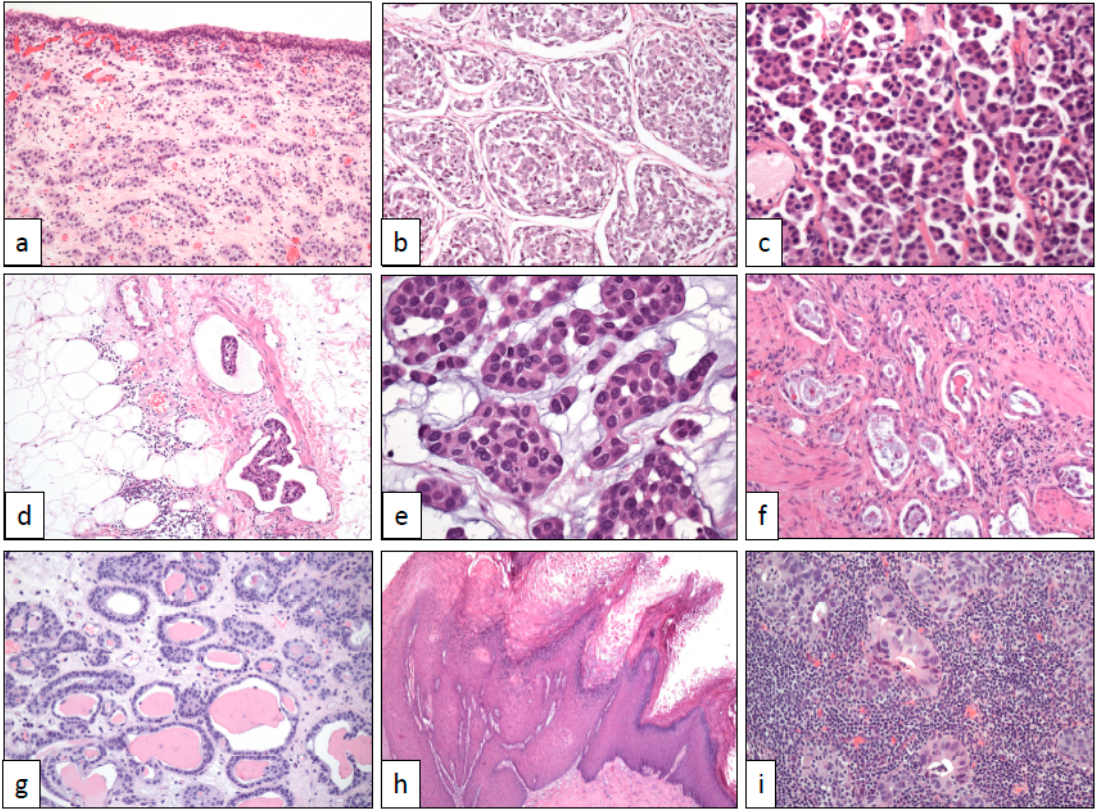
Figure 1. Architectural changes in bladder cancer (with original magnifications included). ( a ) Nested pattern (×100), ( b ) large nested pattern (×100), ( c ) micropapillary pattern (×250), ( d ) vascular invasion in the micropapillary pattern (×100), ( e ) myxoid basophilic stroma (×400), ( f ) small tubules (×100), ( g ) microcystic pattern (×100), ( h ) verrucous pattern (×40), and ( i ) lymphoepithelioma-like pattern (×250).